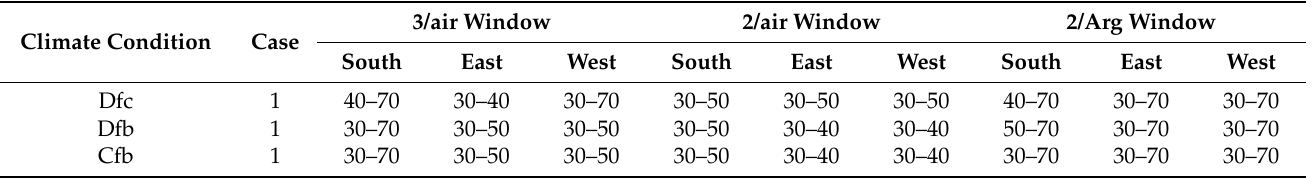
Table 7. Optimal WWR ranges for studied cases in the studied climate conditions and orientations in cold climates. Case 1 refers to base case where automatic lighting control was